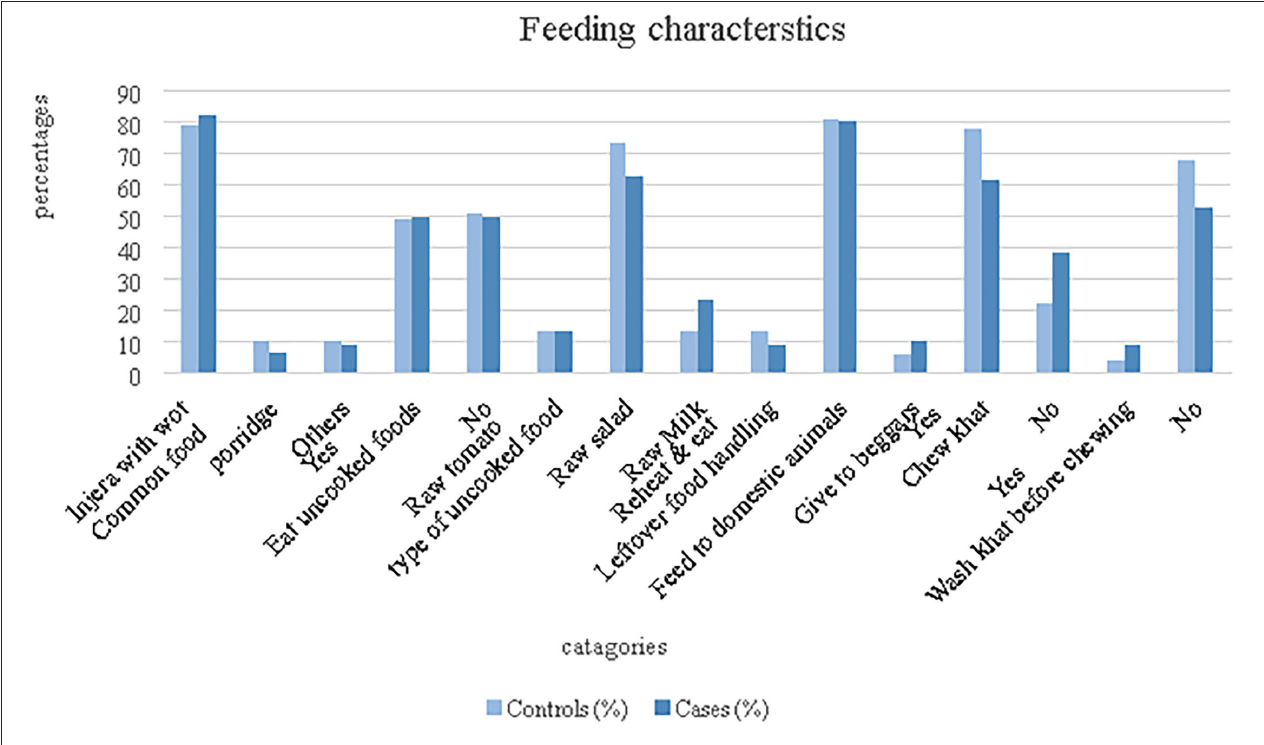
FIGURE 4 | Feeding characteristics of the population in Erer woreda, 2019.